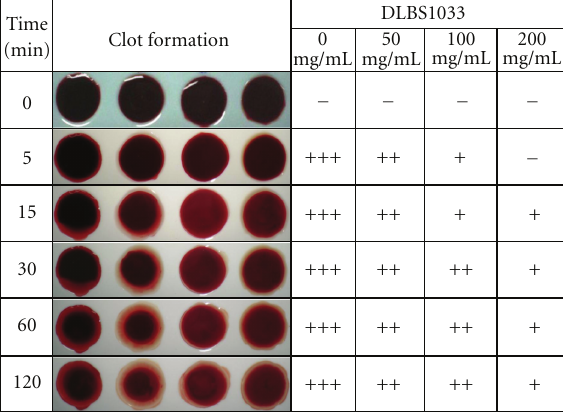
Figure 8: Ex vivo antithrombotic e ff ect of DLBS1033. The clot formation was inhibited after the administration of DLBS1033. +++: fully clotted; high clotting consistency; ++: partially clotted, medium clotting consistency; +: slightly clotted, low clotting consistency; − : no clot occurred.